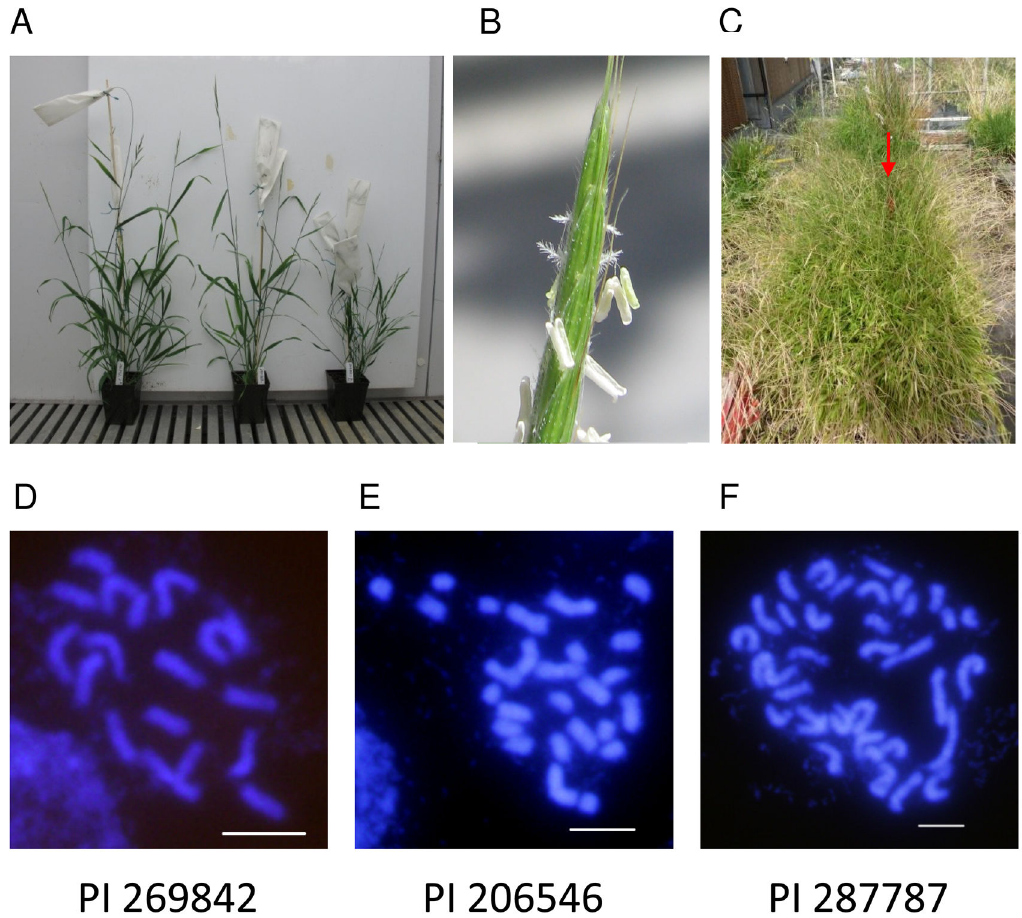
Figure 3. Growth habit and chromosomes. (a) Flowering plants in the growth chamber. The accessions are, from left to right, PI296842, PI297868 and PI204863. Note the variation in height. The pots are 10 cm tall. (b) Close up of flowers. Note the fully exerted anthers and stigmas. (c) Bench full of transgenic plants surrounding a non-transgenic plant to determine pollen flow. The red arrow is pointing to a red stake in the pot of the non-transgenic plant. (d-f) Mitotic chromosome spreads of the indicated accessions. Scale bars = 5